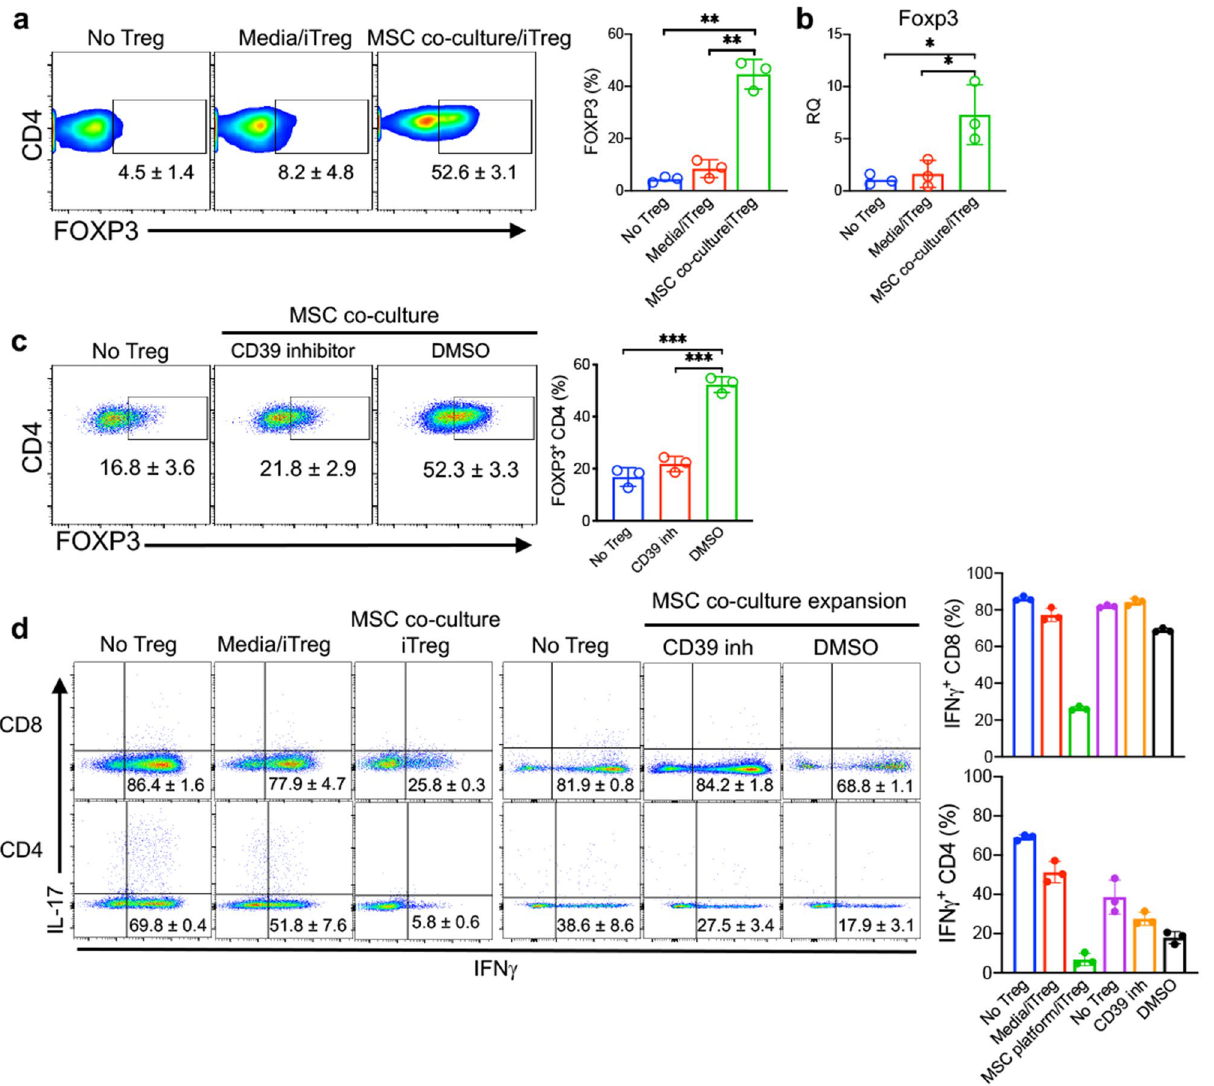
Figure 7. MSC co-culture expanded iTregs suppress effector T cell response in GVHD inflammation. ( a ) FOXP3 + CD4 T cells were measured from no iTreg, media expanded iTreg, and MSC co-culture